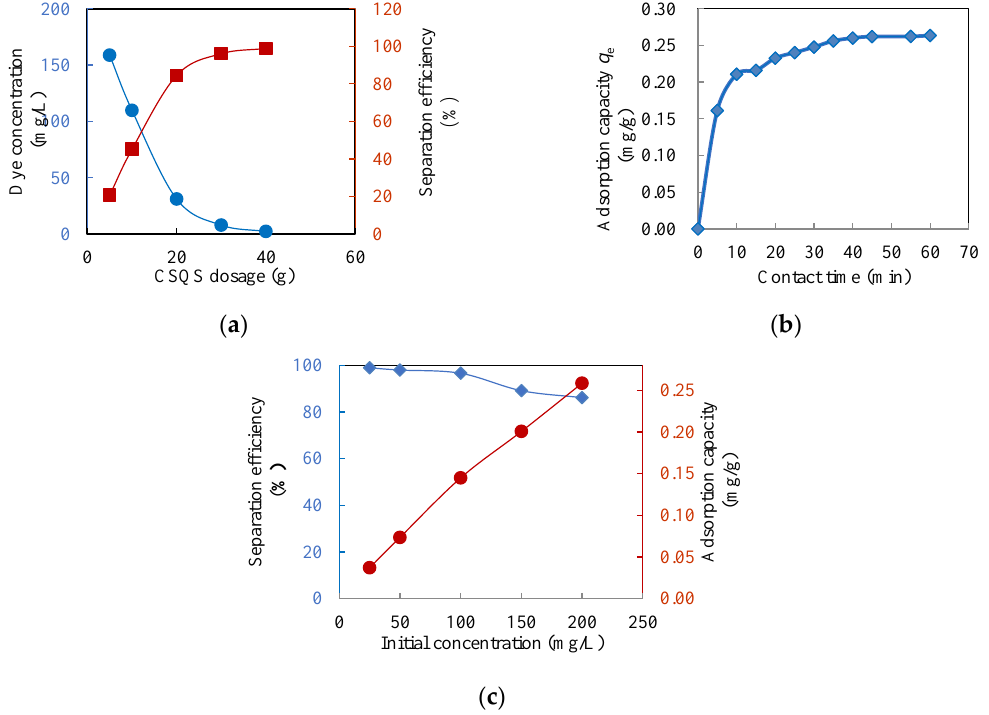
Figure 13. The effect of CSQS dosage, contact time, and initial concentration on the adsorption of methylene blue (MB). ( a ) The influence of quartz sand dosage on the concentration and separation efficiency after adsorption. The initial concentration is 200 mg/L and the contact time is 1 h. ( b ) The influence of contact time on the adsorption capacity of quartz sand. The initial concentration is 200 mg/L and CSQS dosage is 20 g. ( c ) The effect of initial concentration on MB removal rate and adsorption capacity. The CSQS dosage is 20 g and the oscillation time is 1 h.